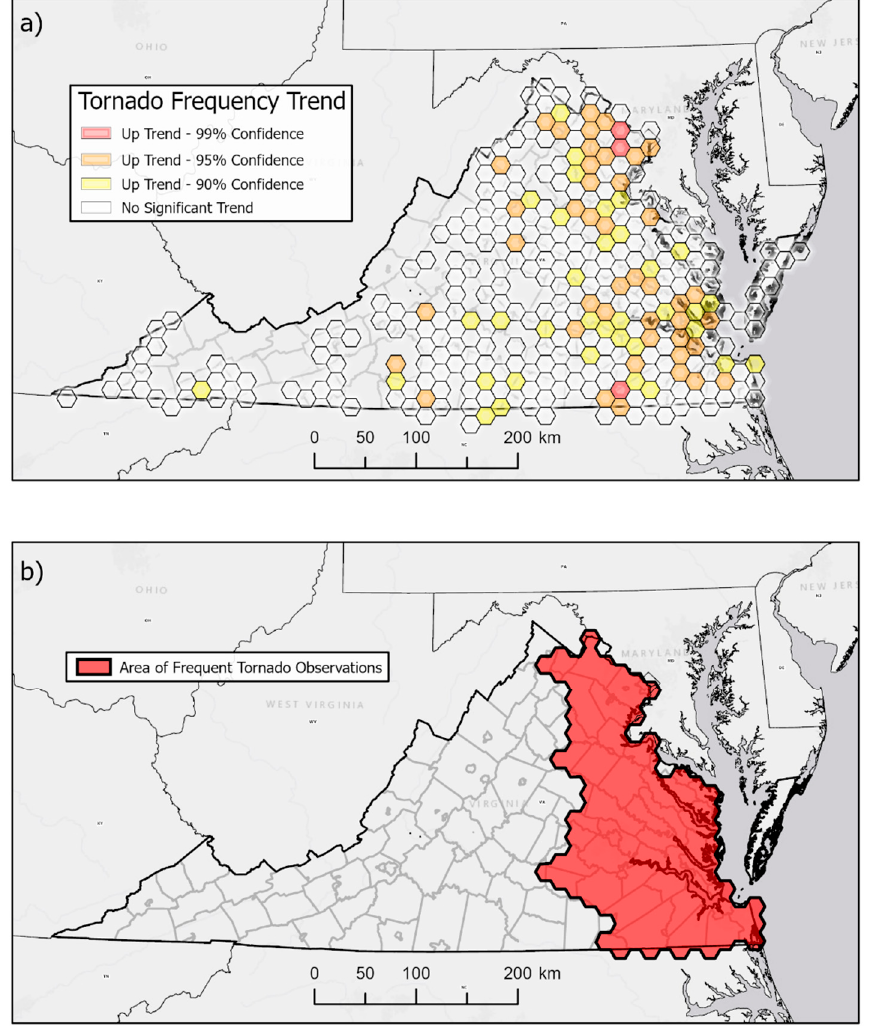
Figure 7. Space-time cube results for ( a ) 2D temporal trend confidence (99%, 95%, 90%, no signifi- cance) and ( b ) concentration and increasing frequency of Virginia tornadoes.